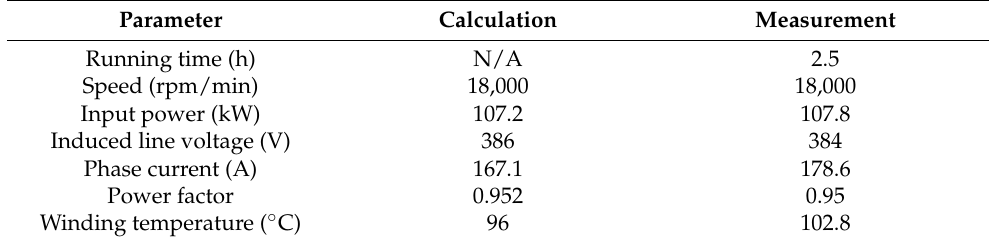
Table 5. Comparison between numerical calculation and experimental